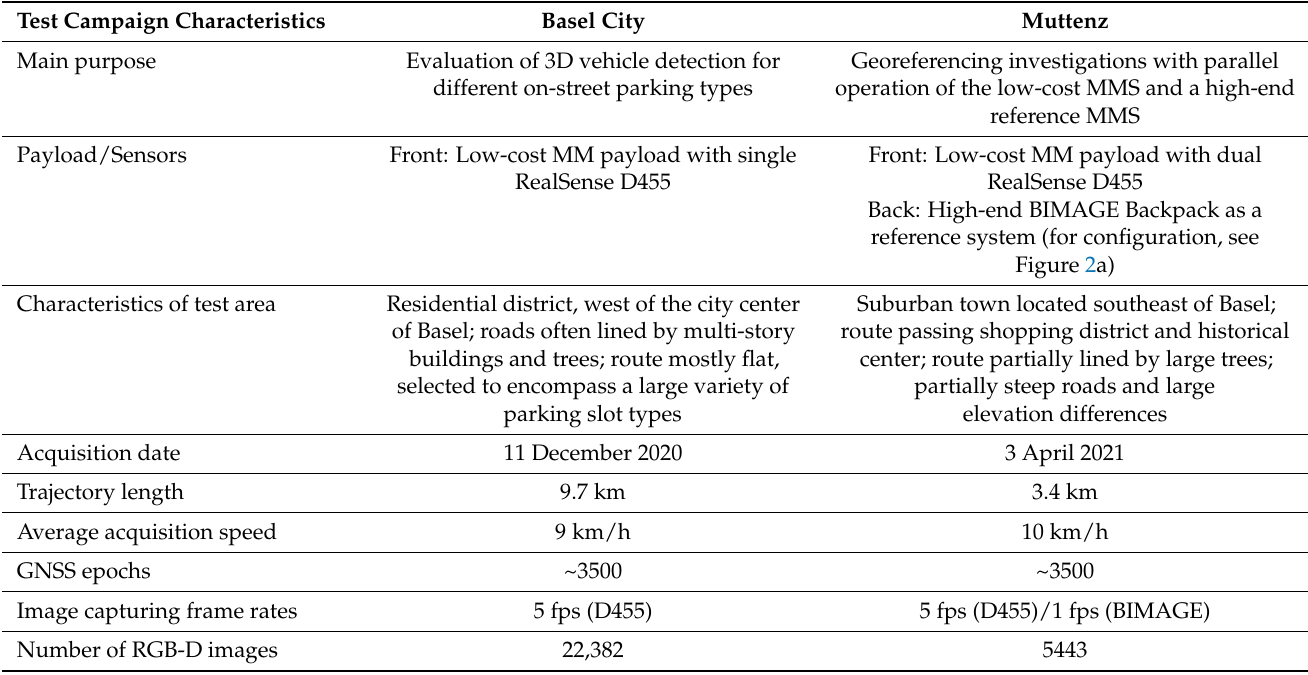
Table 2. Overview of two mobile mapping campaigns with their main purpose, characteristics, and the resulting datasets. Test Campaign Characteristics